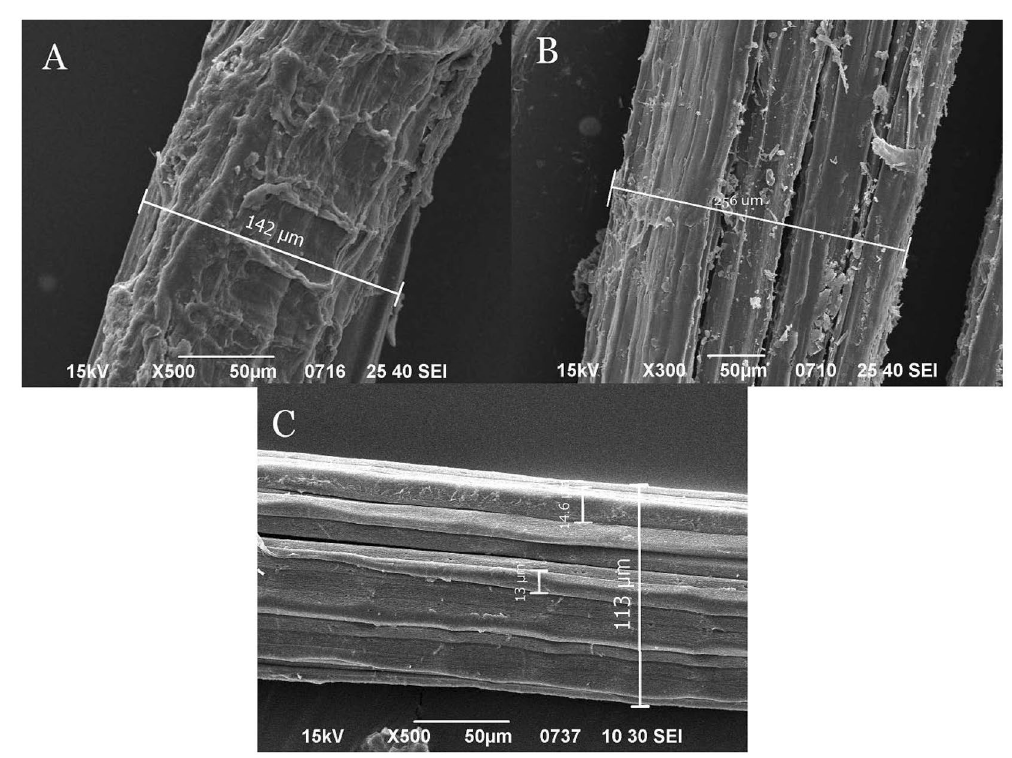
Figure 1. SEM image of fiber bundles ( A ) raw kenaf, ( B ) semi-degummed kenaf and ( C ) degummed